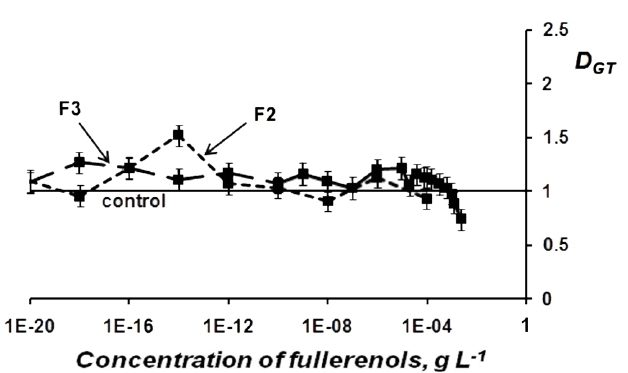
Figure 4. Detoxification coefficients D GT vs. concentration of fullerenols F2 and F3 in solutions of 1,4-benzoquinone (10 ⁻4 М) for the enzyme-based assay.